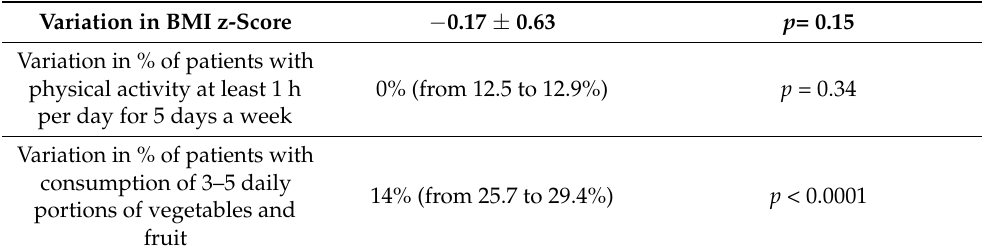
Table 4. Anthropometric and lifestyle variation from baseline to follow up of overweight and obese subjects enrolled in the outpatient clinic ( n =